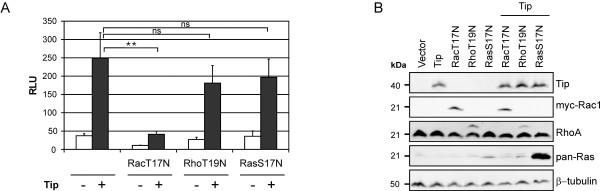
Influence of dominant-negative GTPases on SRF activation. Jurkat T cells were transiently transfected with expression plasmids coding for myc-Rac1-T17N (RacT17N), RhoA-T19N (RhoT19N) and H-Ras-S17N (RasS17N) alone or in combination with a Tip expression construct. (A) Activity of cotransfected p3D.A-Luc displayed as mean values and standard deviation of three independent experiments. Statistical significance, p > 0.05 (ns); p < 0.01 (**). (B) Representative expression control carried out by immunoblot analysis. Detection of β-tubulin served as a loading control